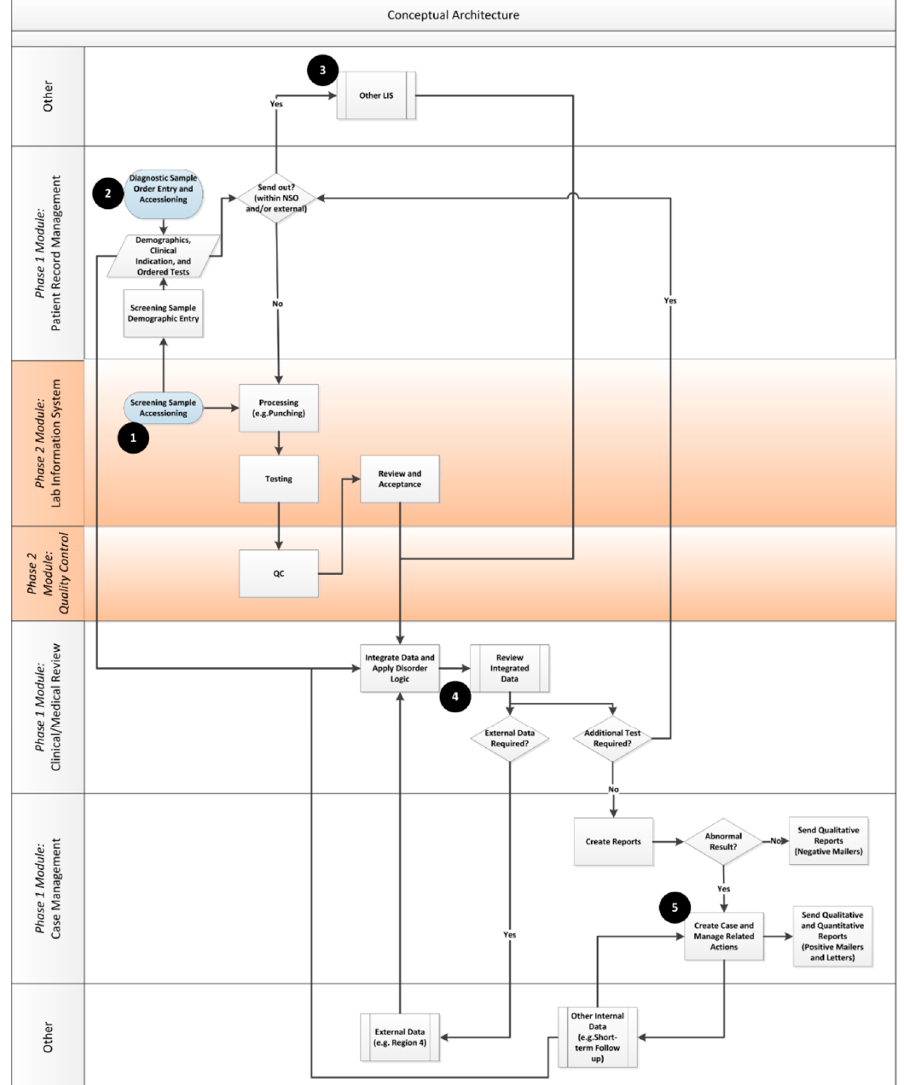
Figure 4. NSO Functional Architecture. The numbers (1–5) provide a reference point to follow the NSO data-flows from entry of the samples into the lab (1) through the sending of reports to submitters (5).